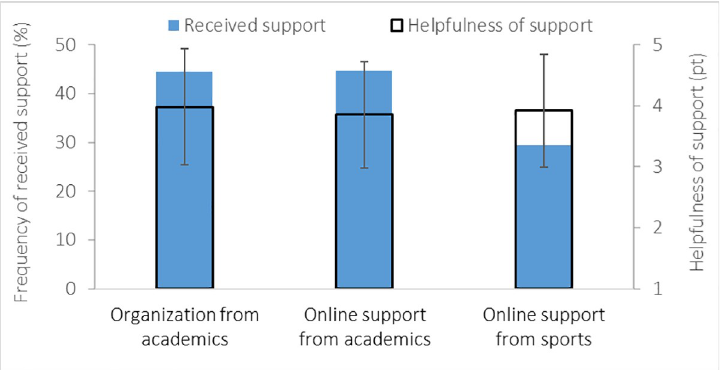
Fig 10. Mean and standard deviation of organizational and online support provided by academics and sports (left vertical axis) and helpfulness of organizational and online support if received (right vertical axis).